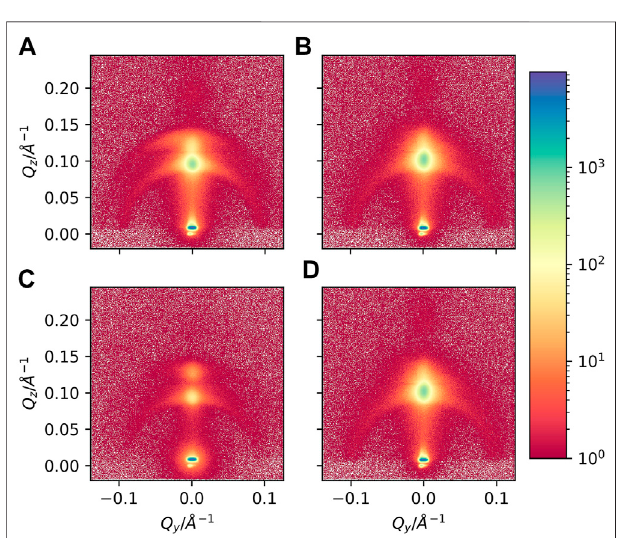
FIGURE 7 | Representative GISANS images of samples with 1 M NaCl ( A : 16.4 ° C and B : 37.1 ° C) and 2 M NaCl ( C : 16.4 ° C and D : 37.1 °